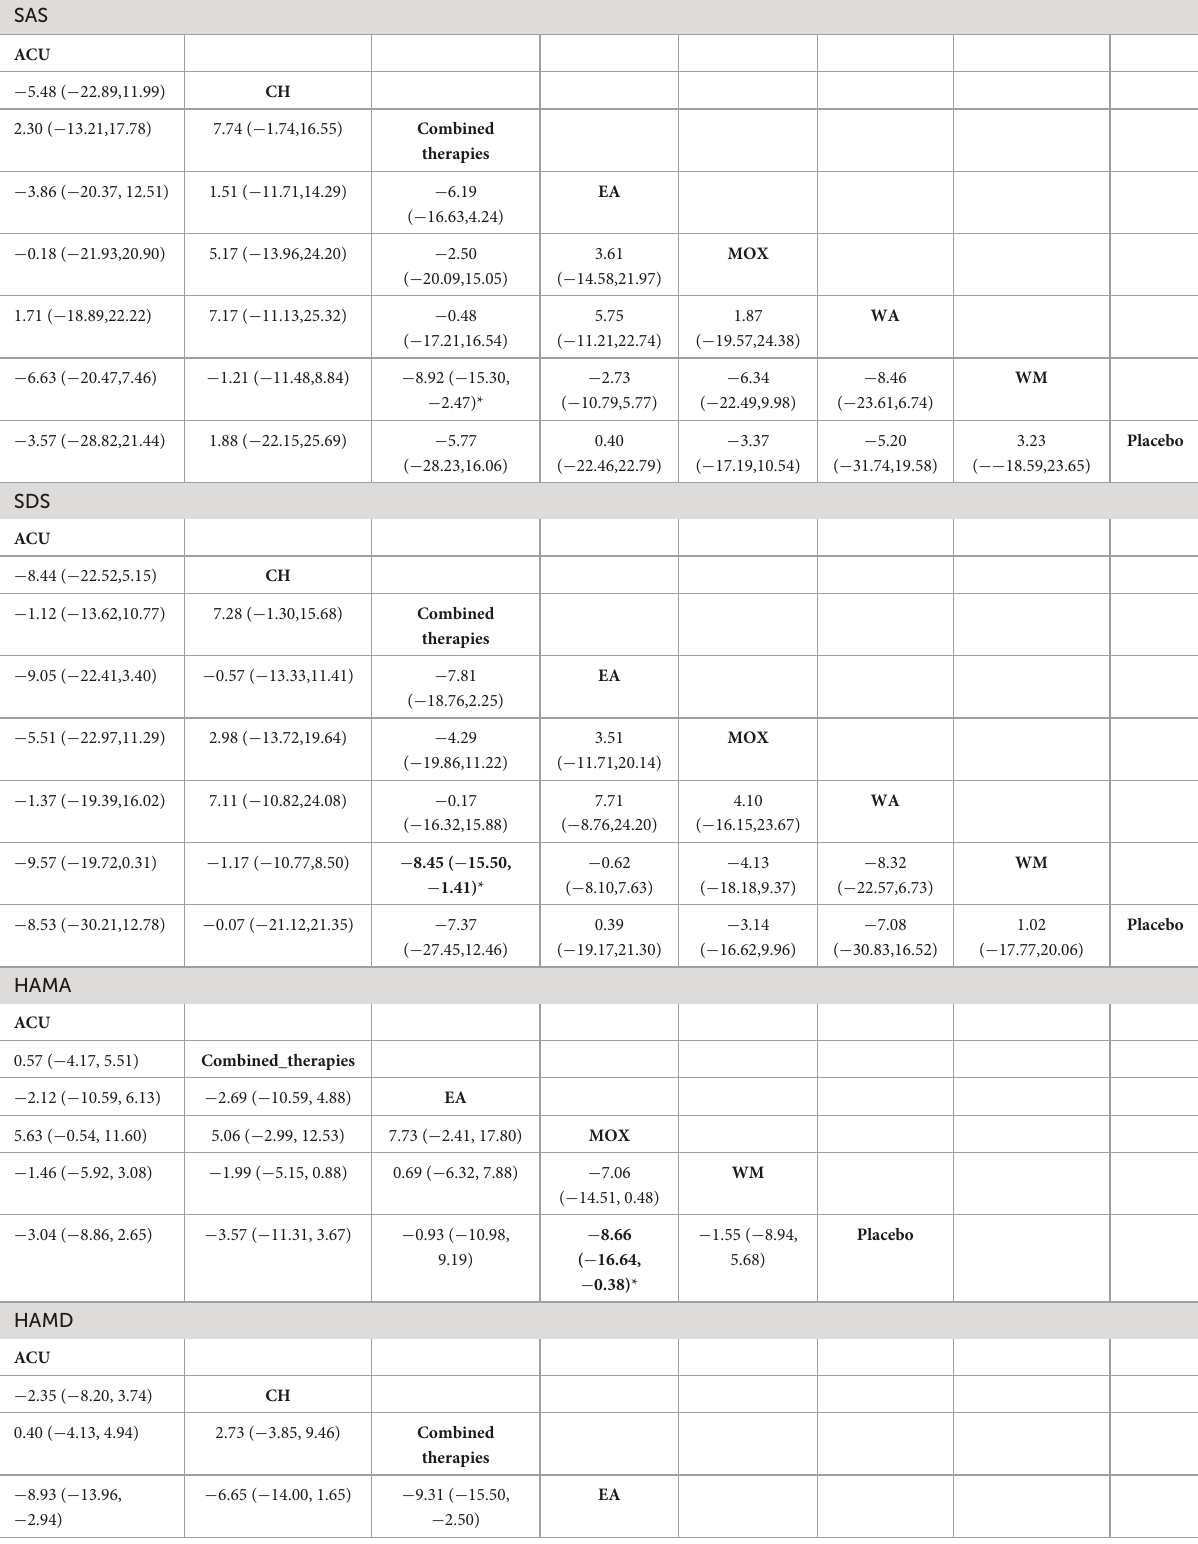
TABLE 4 Network meta-analysis